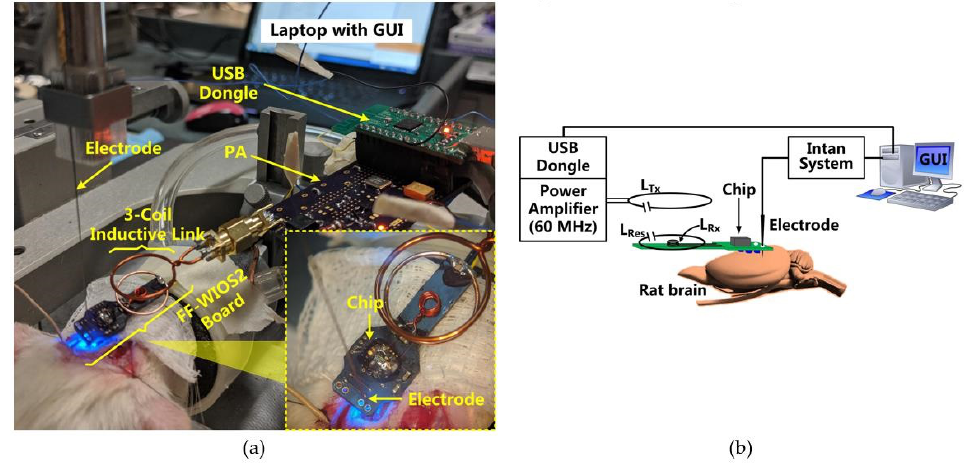
Figure 6. ( a ) In vivo experimental setup with its ( b ) block diagram.